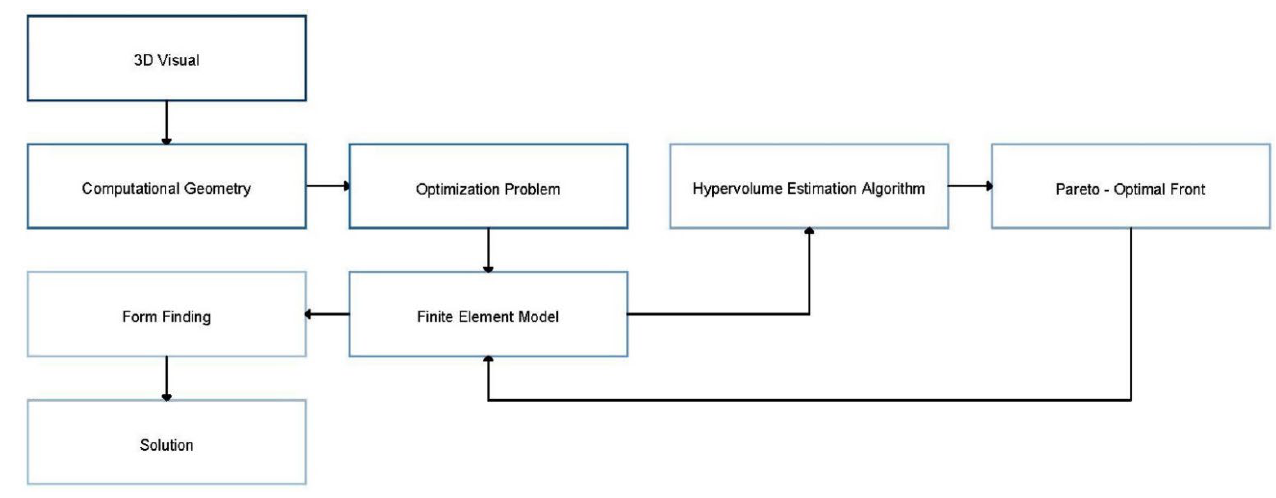
Figure 2. Tools workflow.